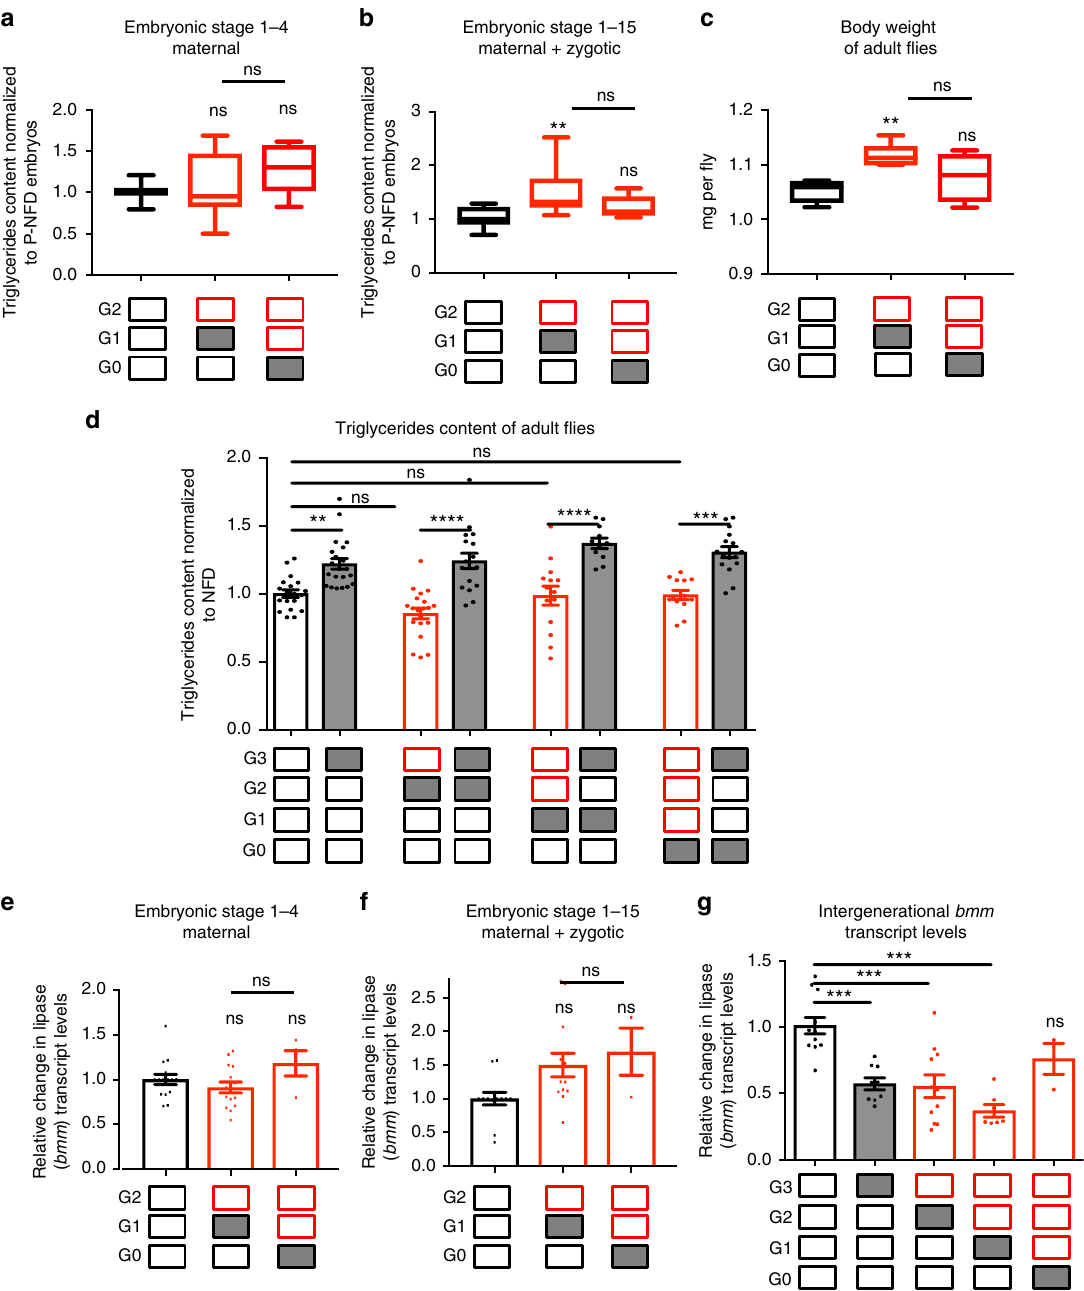
Fig. 2 Parental HFD causes intergenerational elevation of lipid content and decreased bmm RNA levels. TAG content of a early-stage embryos (stages 1 –